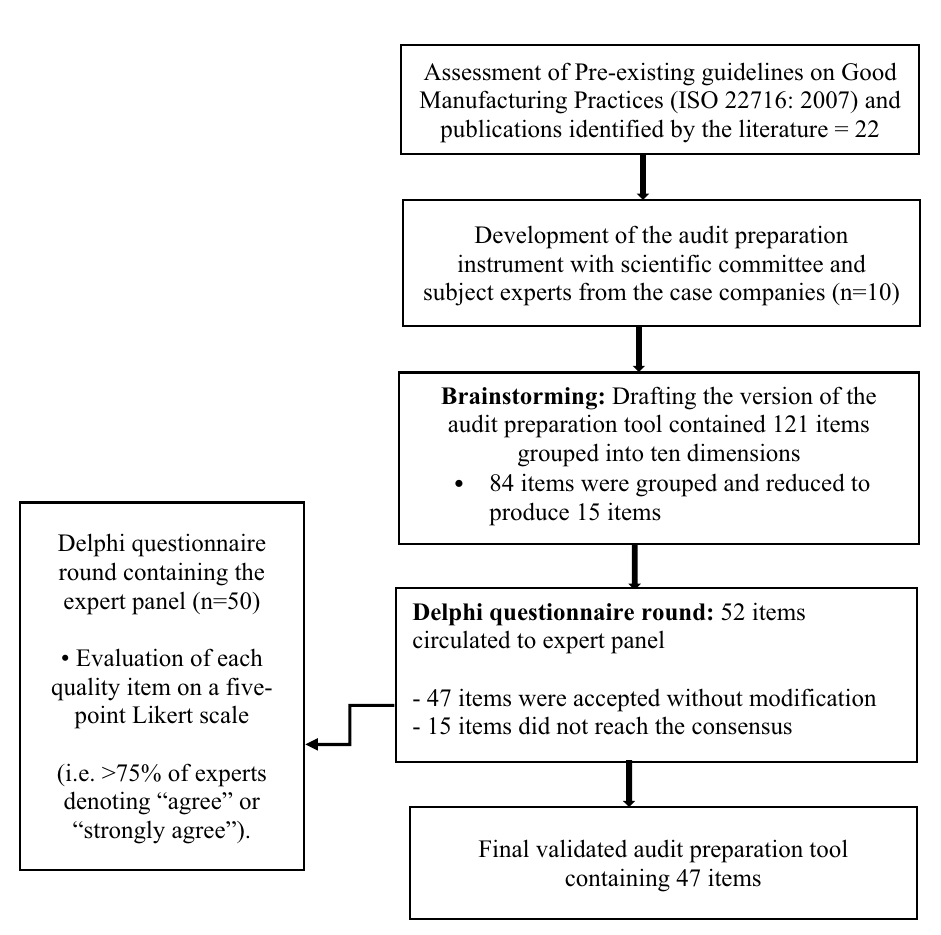
Figure 1. Audit preparation tool